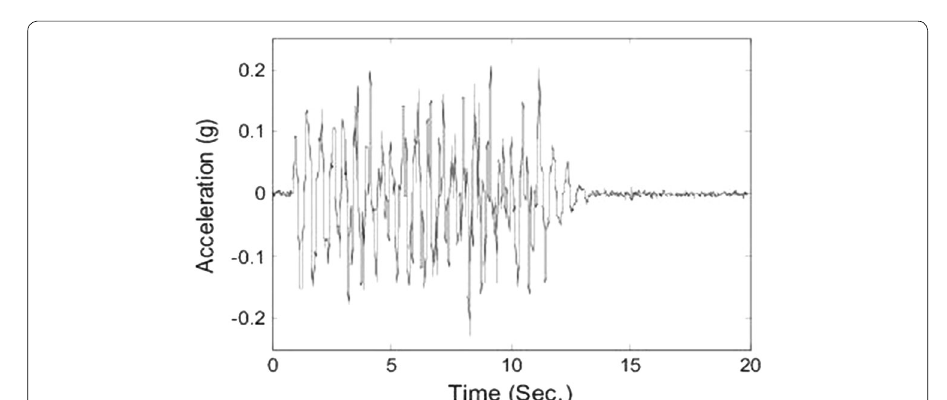
Fig. 2 Horizontal input excitation at bottom [23]